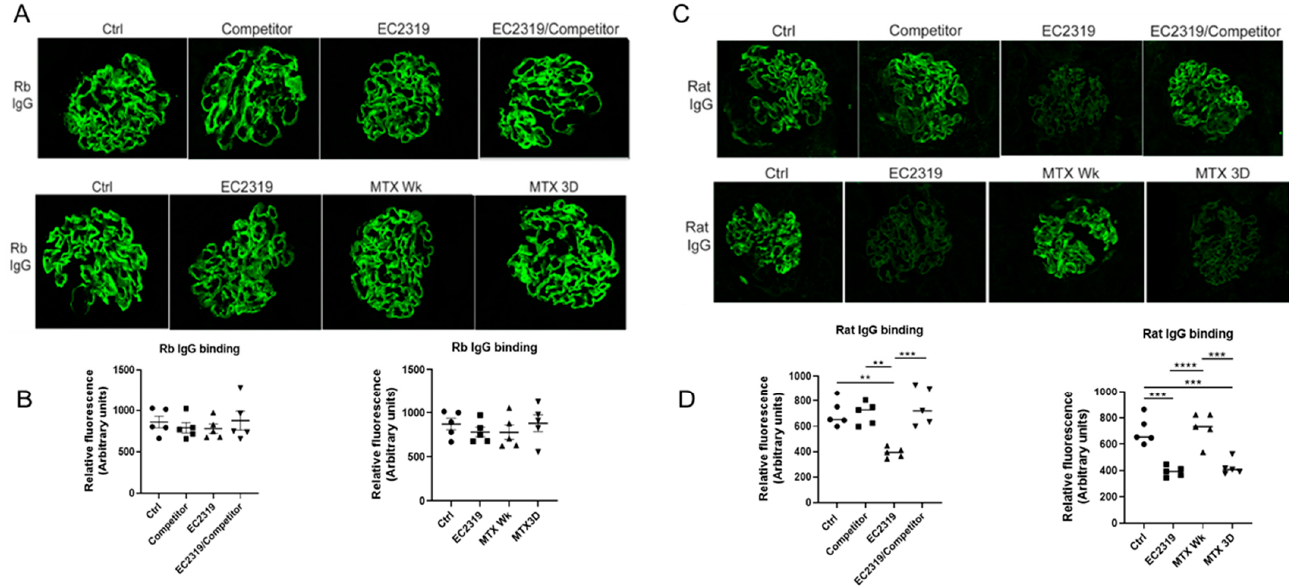
Figure 10. Glomerular rabbit IgG deposition is not affected by treatment with EC2319, EC2319/FA competitor, or MTX; however, glomerular rat IgG deposition is decreased in EC2319- and MTX Wk-treated rats with GN. ( A ) Immunofluorescence staining of rabbit IgG reveals rabbit IgG along the capillary walls of glomeruli in a linear pattern with no discernible difference in the intensity between the groups. ( B ) Quantification intensity of rabbit IgG immunofluorescence staining. ( C ) Immunofluorescence staining of rat IgG shows a decrease in the intensity within the glomeruli in rats treated with EC2319 and MTX Wk. ( D ) Quantification of rat IgG fluorescence intensity. ** p < 0.01, *** p < 0.001, **** p < 0.000. For ( B , D left panel): • Control, (cid:4) Competitor, (cid:78) EC2319, (cid:72) EC2319/Competitor. For ( B , D right panel): • Control, (cid:4) EC2319, (cid:78) MTX Wk, (cid:72)